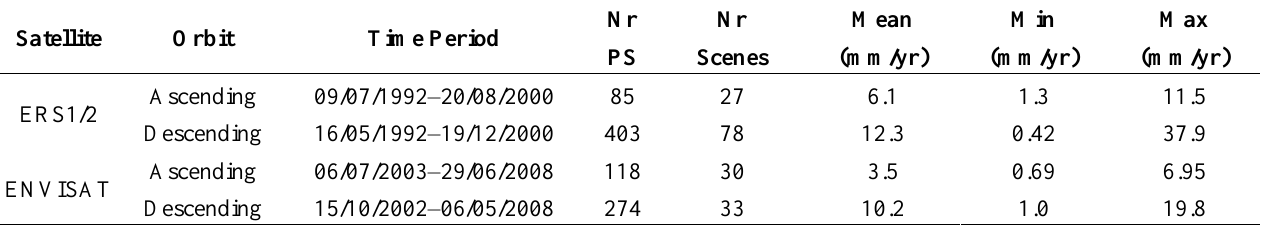
Table 2. Time period, number of Persistent Scatterers (PS ® ) within the landslide area, mean, minimum and maximum velocity for each datasets.